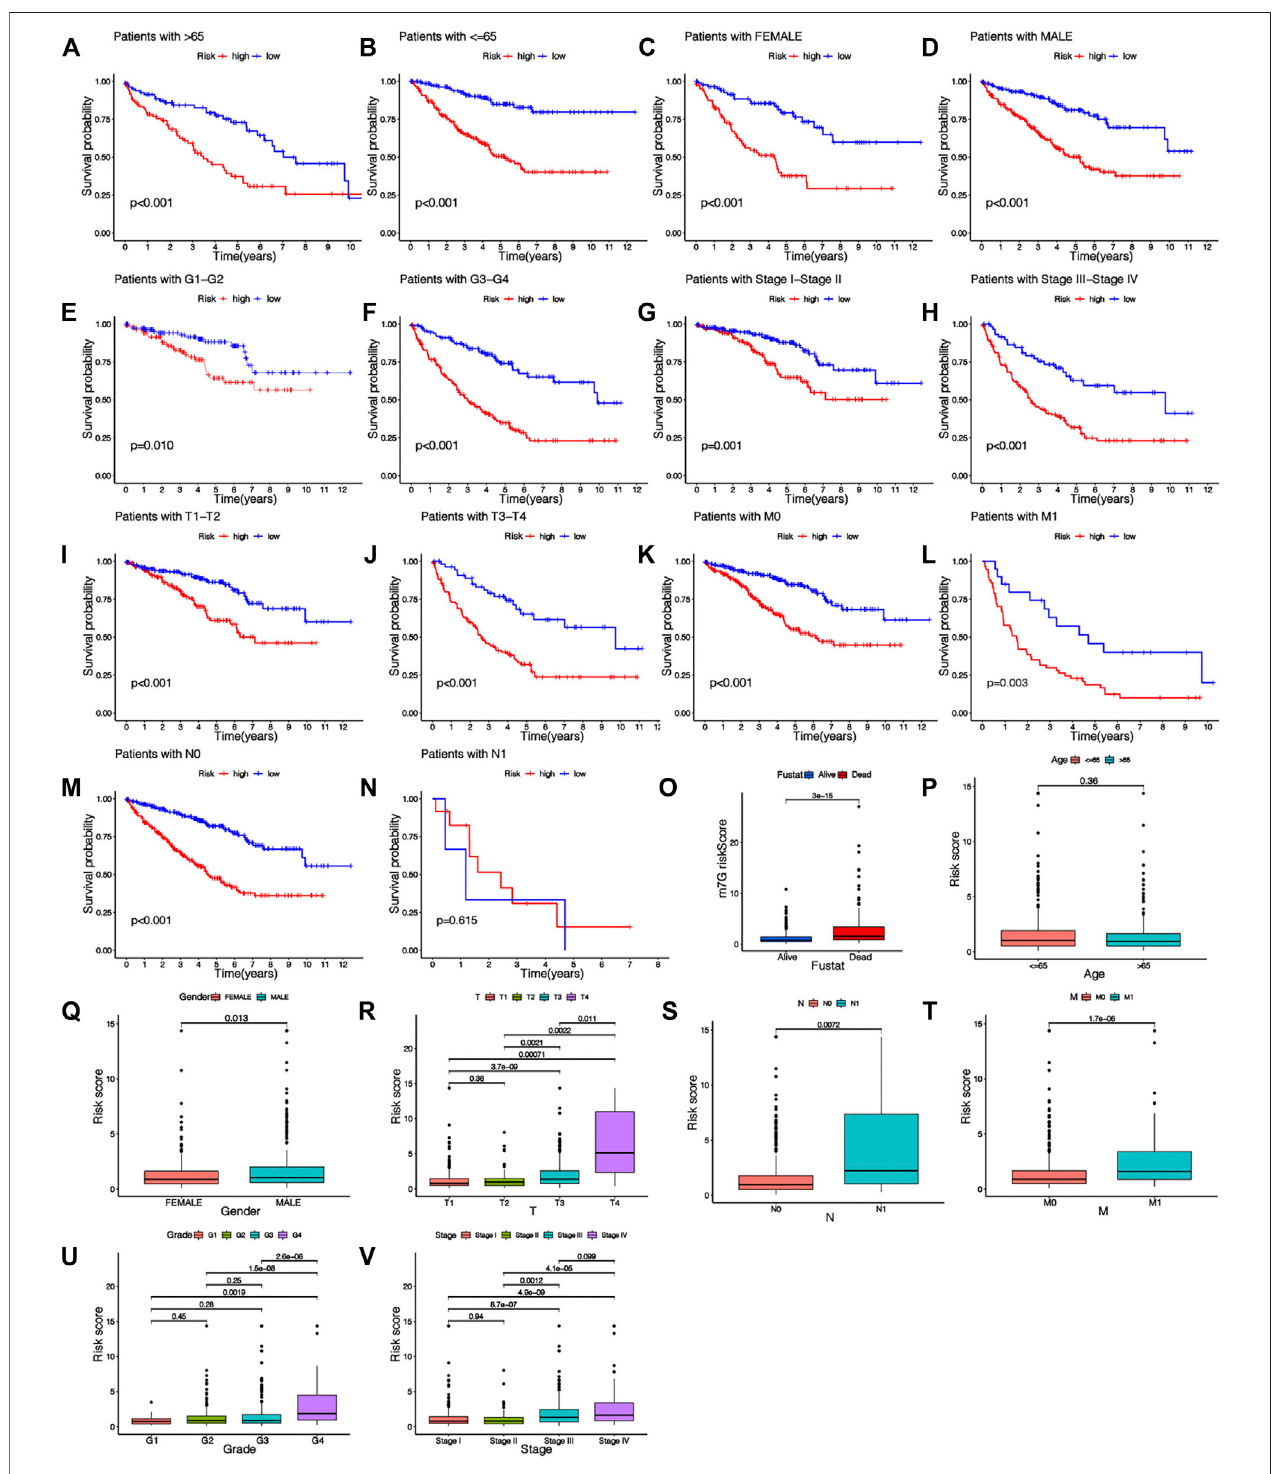
FIGURE 6 | Relationship between risk score and clinical characteristics. (A – N) K-M survival curves for patients with different clinical features. (O – V) The histogram shows the distribution of risk scores among different clinical subgroups.